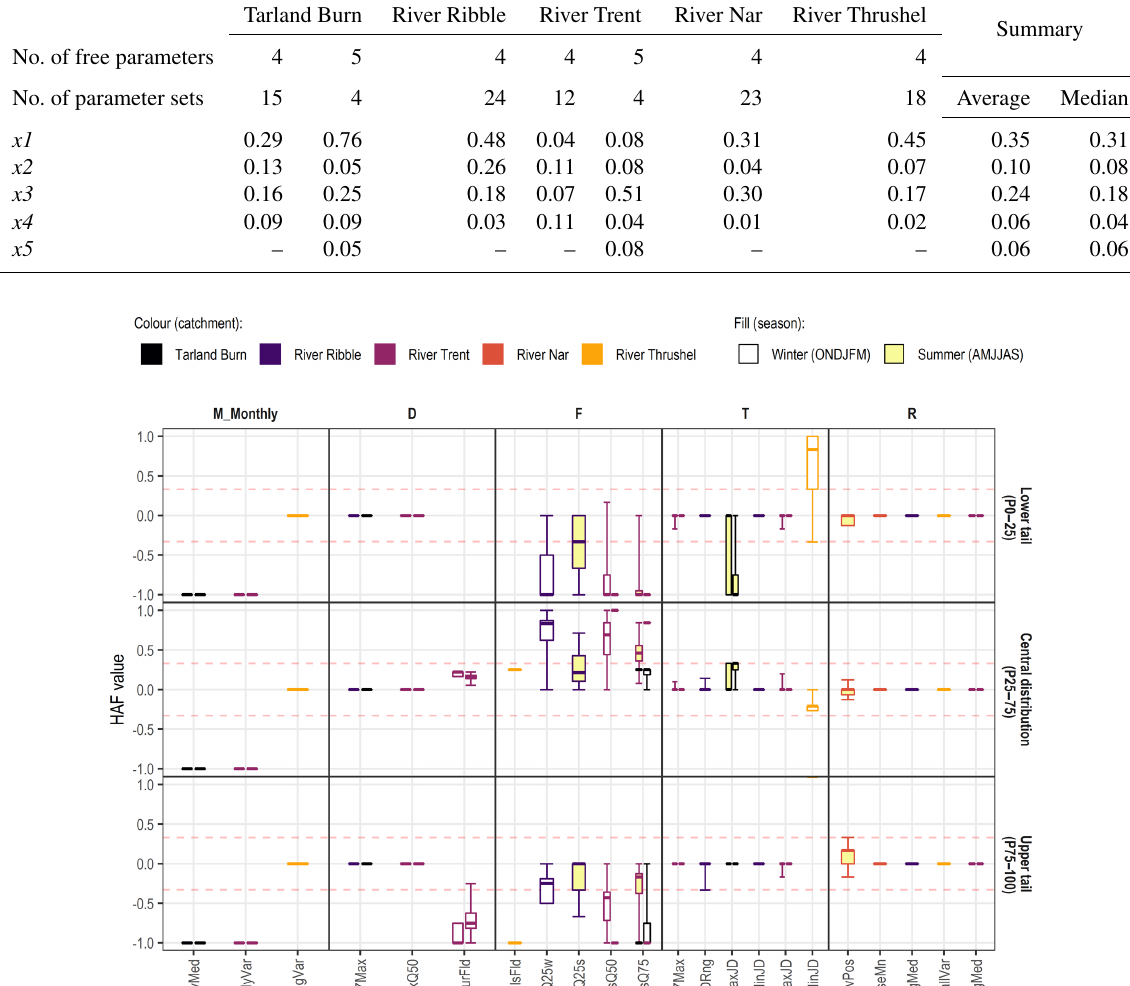
Table 4. Normalized interquartile (IQR) range across the parameter sets for each catchment. The average and mean values across all catch- ments and models are also indicated. The model GR6J was invalidated; therefore, parameter x 6 is omitted.